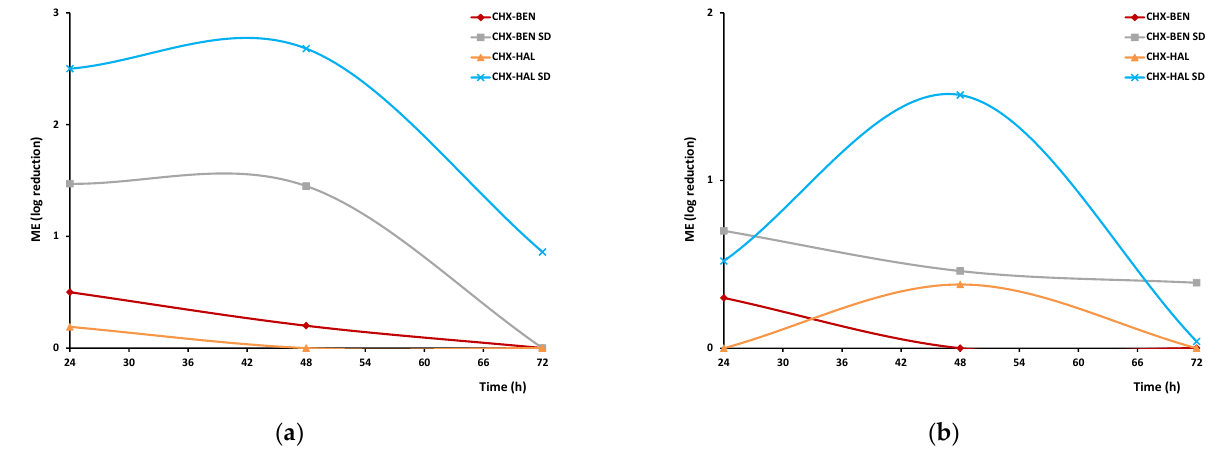
Figure 13. ME effect of nanohybrids against Staphylococcus aureus ( a ) and Pseudomonas aeruginosa ( b ). CHX: chlorhexidine dihydrochloride; BEN: bentonite; HAL: halloysite; CHX–BEN and CHX–HAL: nanohybrids obtained by intercalation solution technique; CHX–BEN SD and CHX–HAL SD: nanohybrids obtained by spray-drying technique.